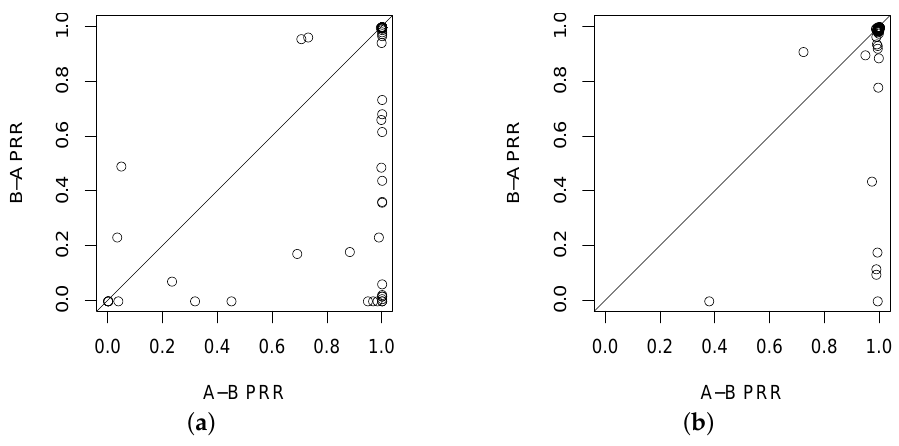
Figure 6. Illustration of link asymmetry under two forest environments. ( a ) Bajia; ( b ) Campus.